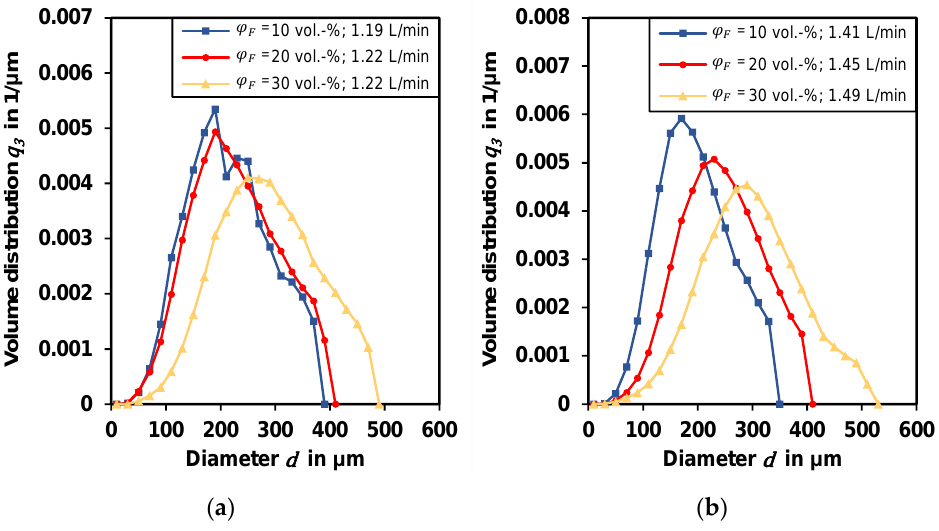
Figure 8. ( a ) Measured DSDs at an impeller speed of 𝑁 = 375 rpm, a total flow rate of 𝑉̇ 𝑡𝑜𝑡 ≈ 1.2 L/min at different feed phase ratios measured at position 𝑀𝑃 1 . ( b ) Measured DSD’s at an impeller speed of 𝑁 = 425 rpm, a total flow rate of 𝑉̇ 𝑡𝑜𝑡 ≈ 1.3 L/min at different feed phase ratios measured at position 𝑀𝑃 1 .